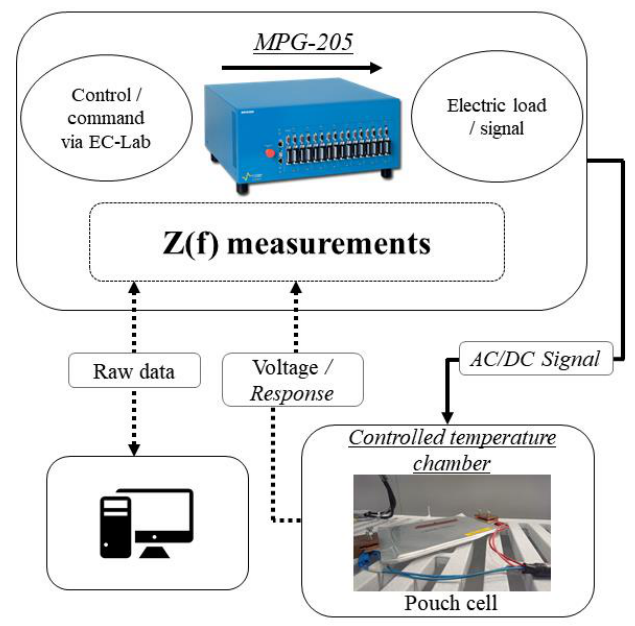
Figure 4. EIS measurement flowchart of this research.